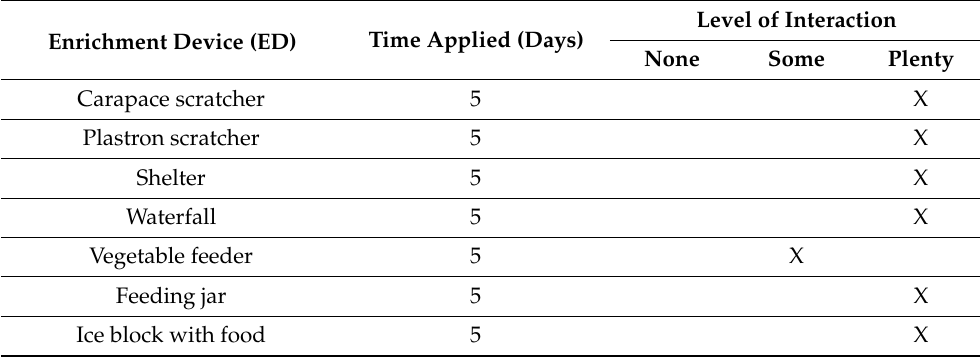
Figure 1. Environmental enrichment devices used in the rehabilitation of an olive ridley turtle ( Lepidochelys olivacea ). ( a ) carapace scratcher (sensory, tactile); ( b ) plastron scratcher (sensory, tactile); ( c ) shelter (structural, physical); ( d ) waterfall (structural, sensory, tactile). Table 2. Level of turtle interaction with the enrichment devices (ED)